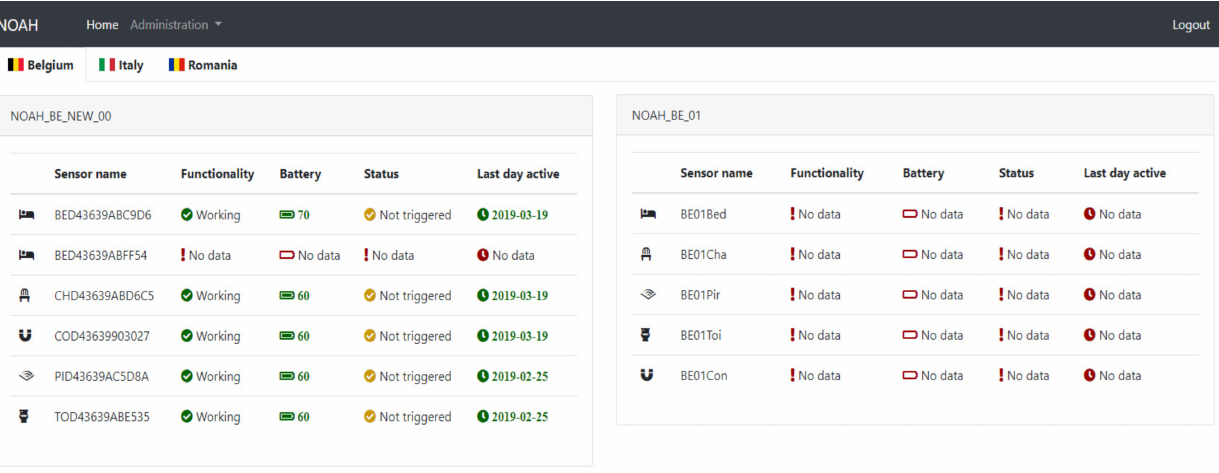
Figure 11. Admin Centre Dashboard.